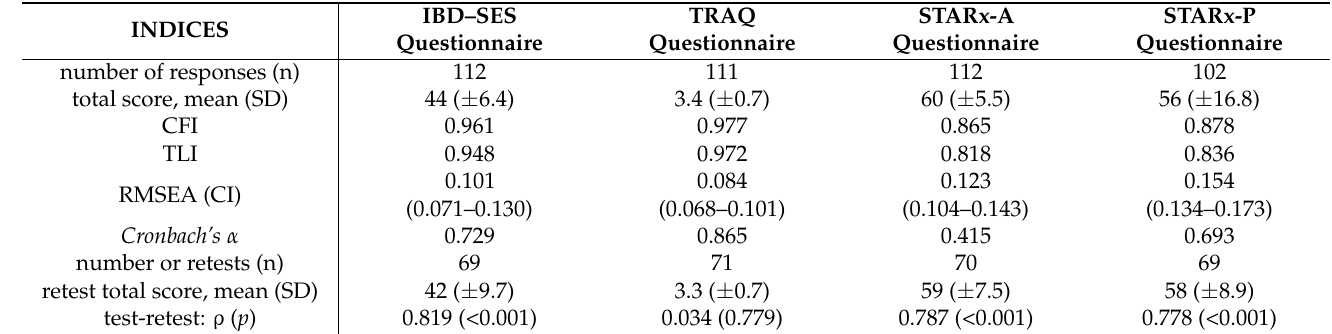
Table 3. Indices of IBD–SES, TRAQ, STARx questionnaire adequacy and